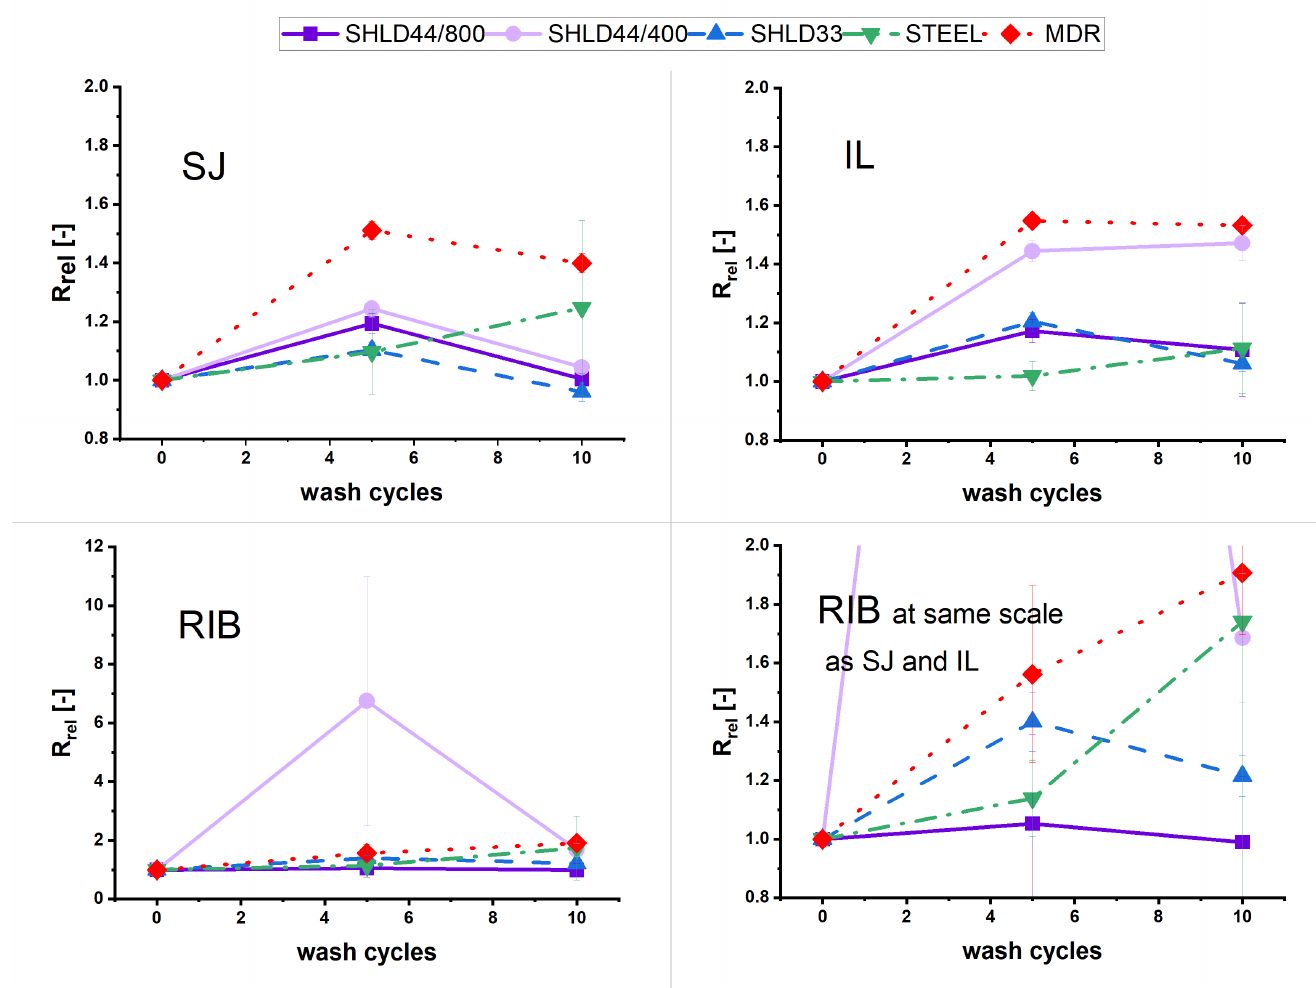
Figure 9. Relative change in resistance for different knit structures after wash